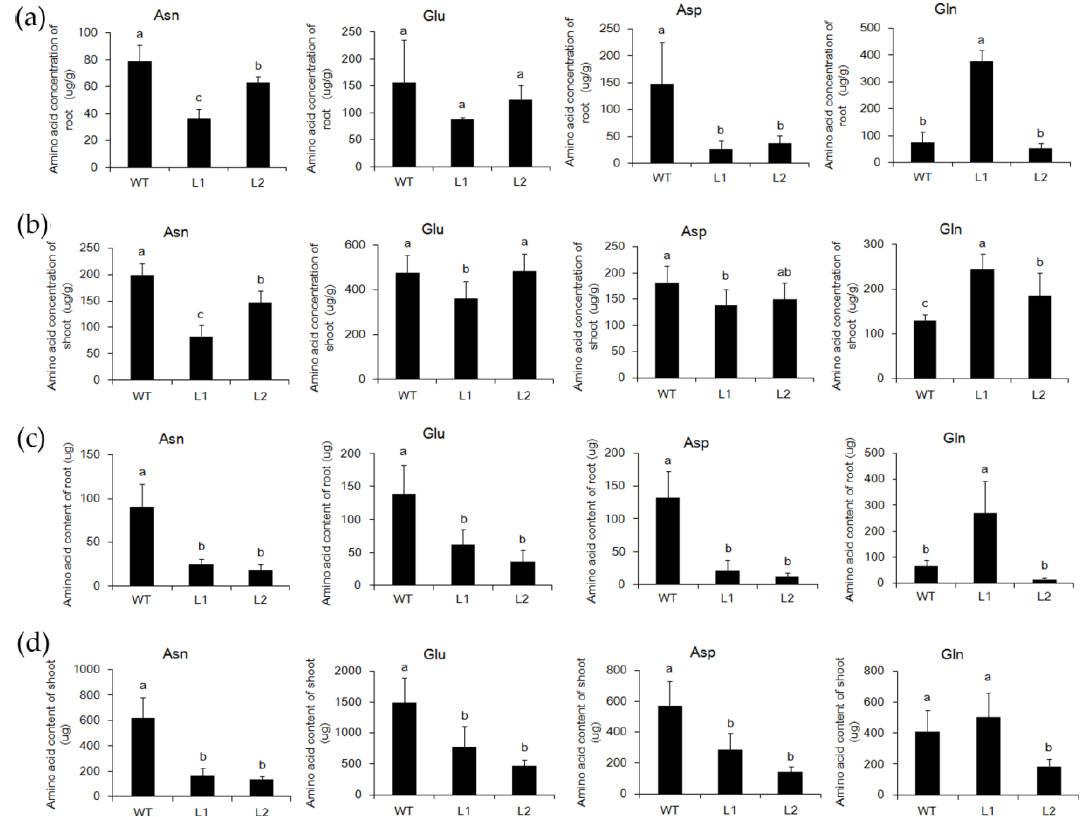
Figure 4. Comparison of asparagine, glutamate, aspartate, and glutamine in shoot and root of WT and L1, L2. ( a ) Concentration of asparagine (Asn), glutamate (Glu), aspartate (Asp), and glutamine (Gln) in the root of WT and L1, L2; ( b ) concentration of Asn, Glu, Asp, and Gln in the shoot of WT and L1, L2; ( c ) content of Asn, Glu, Asp, and Gln in the root of WT and L1, L2; ( d ) content of Asn, Glu, Asp, and Gln in the shoot of WT and L1, L2. Data are mean ± SD ( n ≥ 6). Means with different letters are significantly different.